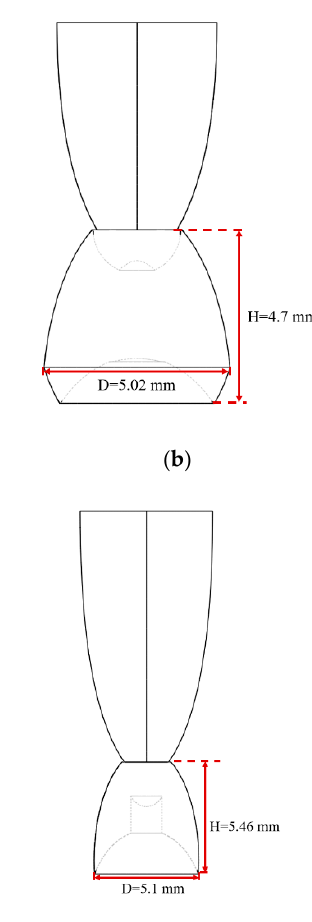
Figure 18. The results of the freeform surface collimators: ( a ) the ray trace and ( b ) the irradiance distribution of the TIR collimator; ( c ) the ray trace and ( d ) the irradiance distribution of the elliptical collimator; ( e ) the ray trace and ( f ) the irradiance distribution of the new TIR collimator; ( g ) the ray trace and ( h ) the irradiance distribution of the new elliptical collimator.